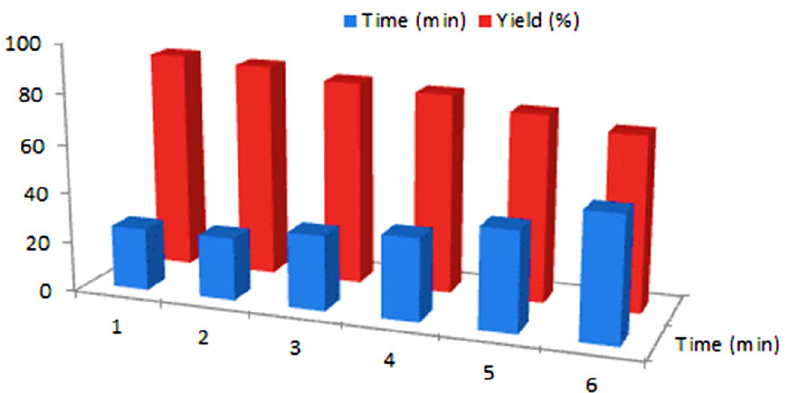
Figure 15. Reusability of MIL-53(Al)-N(CH 2 PO 3 H 2 ) 2